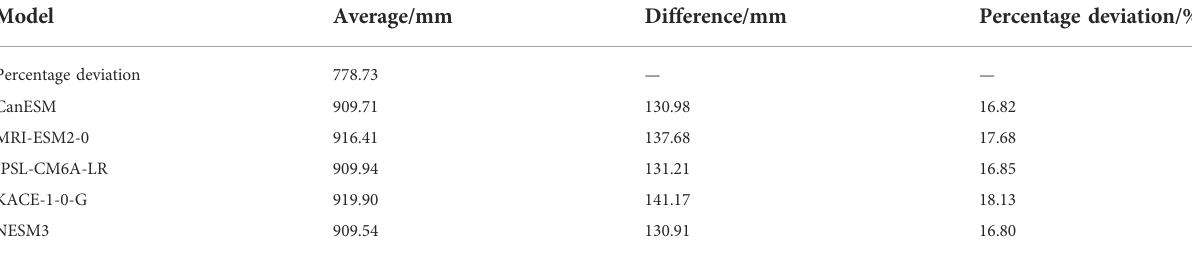
TABLE 3 Difference between fi ve model data and measured